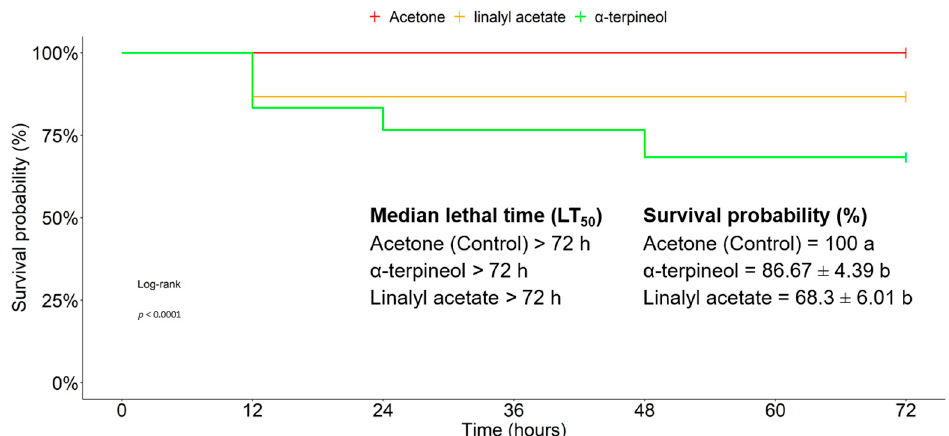
Figure 3. Survival curves, estimated by the Kaplan–Meier method, of Tuta absoluta 2° instar larvae over time submitted to topical application of major compounds of essential oils from Citrus aurantifolia ( α -Terpinol) and linalyl acetate for Citrus aurantium and Citrus aurantium bergamia . 3.5. Life History Tables of T. absoluta Treated with LC 50 of Citrus spp.